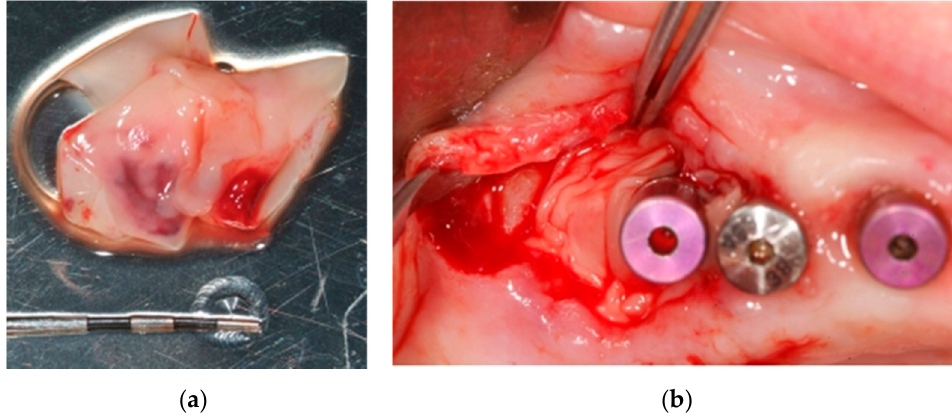
Figure 10. ( a ) Surgical access by a flap without discharge; ( b ) 7 × 4 mm bone fragment. Before suturing the wound, several clots and PRF-L membranes obtained by centrifuge at 2700 rpm for 12 min of 40 mL of the patient’s blood were inserted (Figure 11).